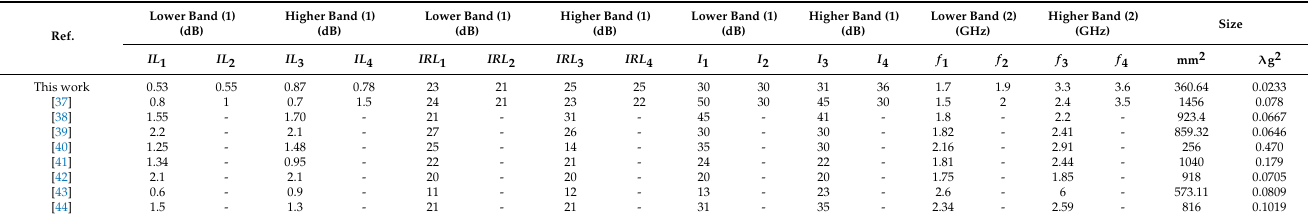
Table 3. Comparison between the designed devices with the previous